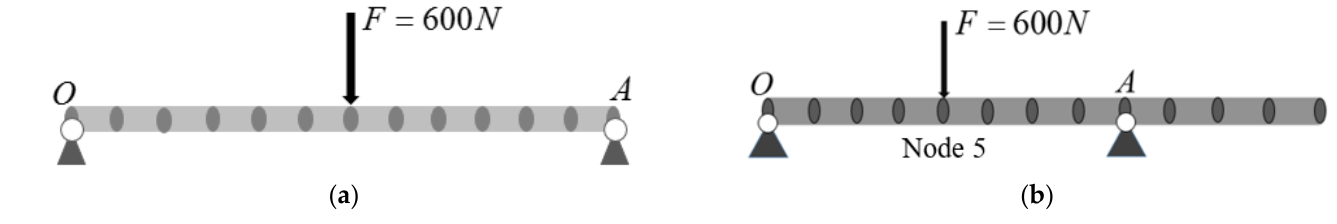
Figure 2. Planar beam. ( a ) simply-support beam; ( b ) extended beam.